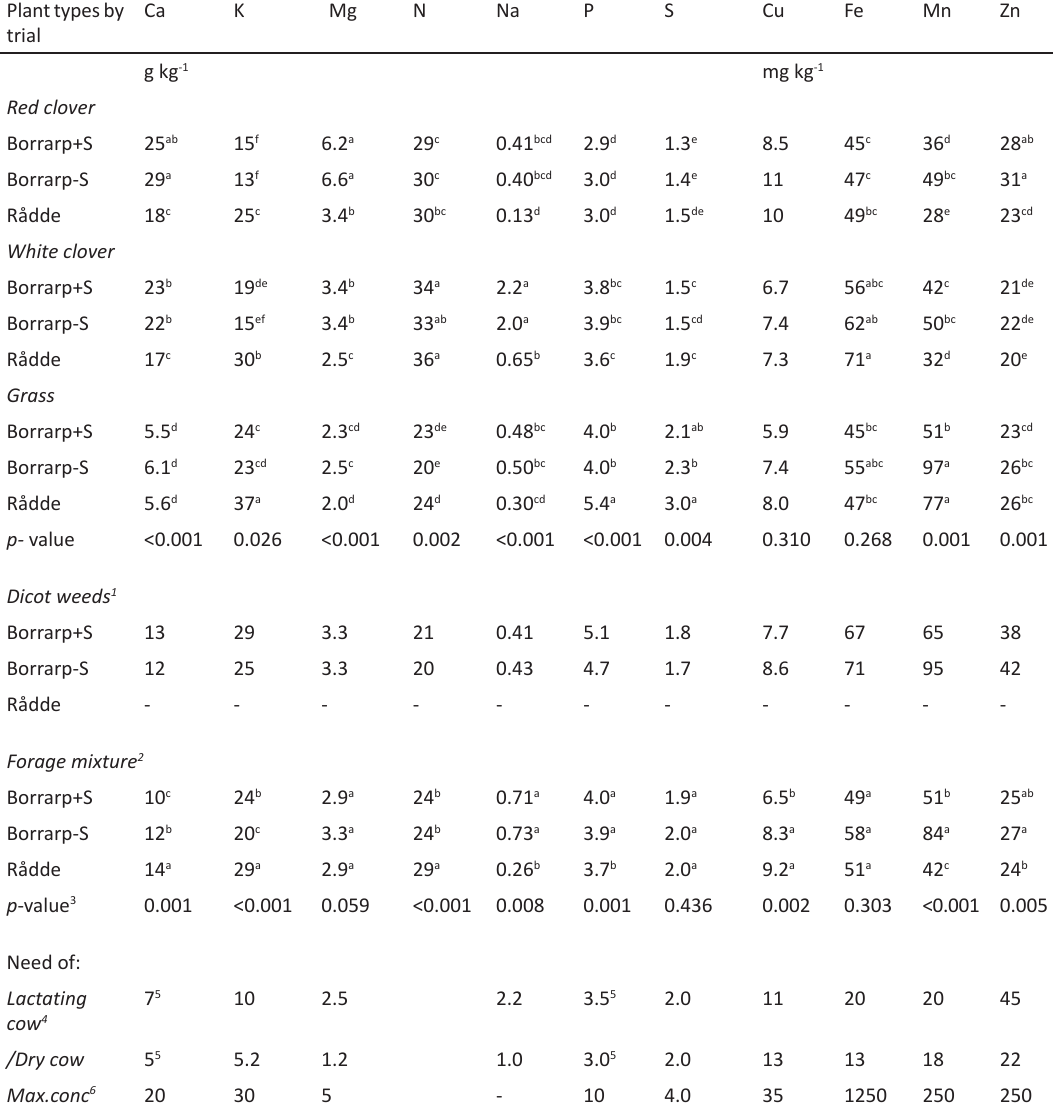
Table 3. Plant type-by-trial effects of nutrient concentrations in red clover, white clover, grass, dicot weeds and trial effects for forage mixture, related to the requirements of lactating and dry dairy cows. The macro elements (Ca, K, Mg, N, Na, P, S) are given in g kg -1 dry weight and the micro elements (Cu, Fe, Mn, Zn) in mg kg -1 dry weight. Plant types by